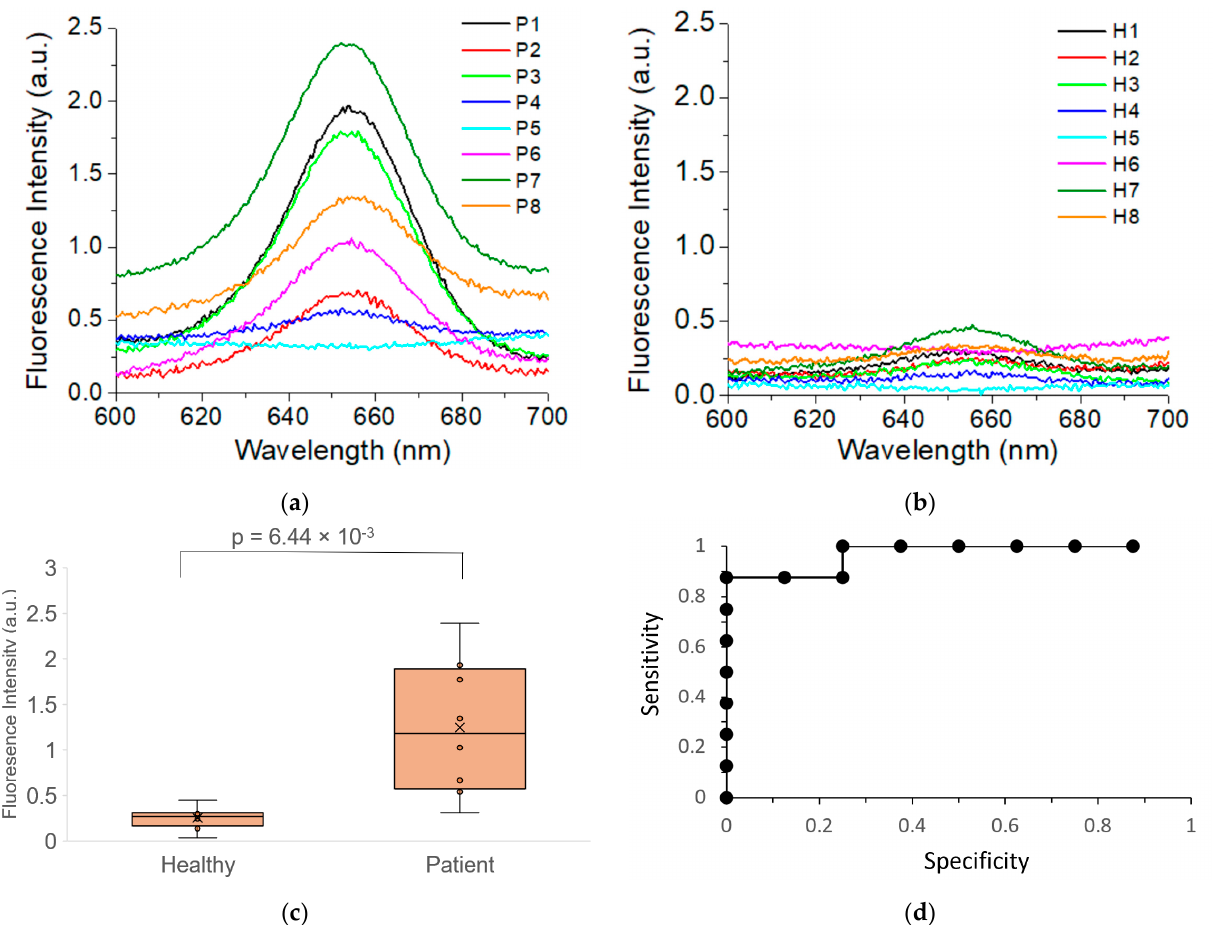
Figure 7. Detection of HER2-positive breast cancer using QD-based EXO assay. ( a ) Average fluorescence spectra from triplicate experiments of HER2-targeted EXOs from each patient with HER2-positive breast cancer. ( b ) Average fluorescence spectra from triplicate experiments of HER2-targeted EXOs from each healthy donor. ( c ) Comparison of the exosomal HER2 expression between patient ( n = 8) and healthy control ( n = 8). ( d ) Roc curve for detecting HER2-positive breast cancer by QD-based EXO assay.